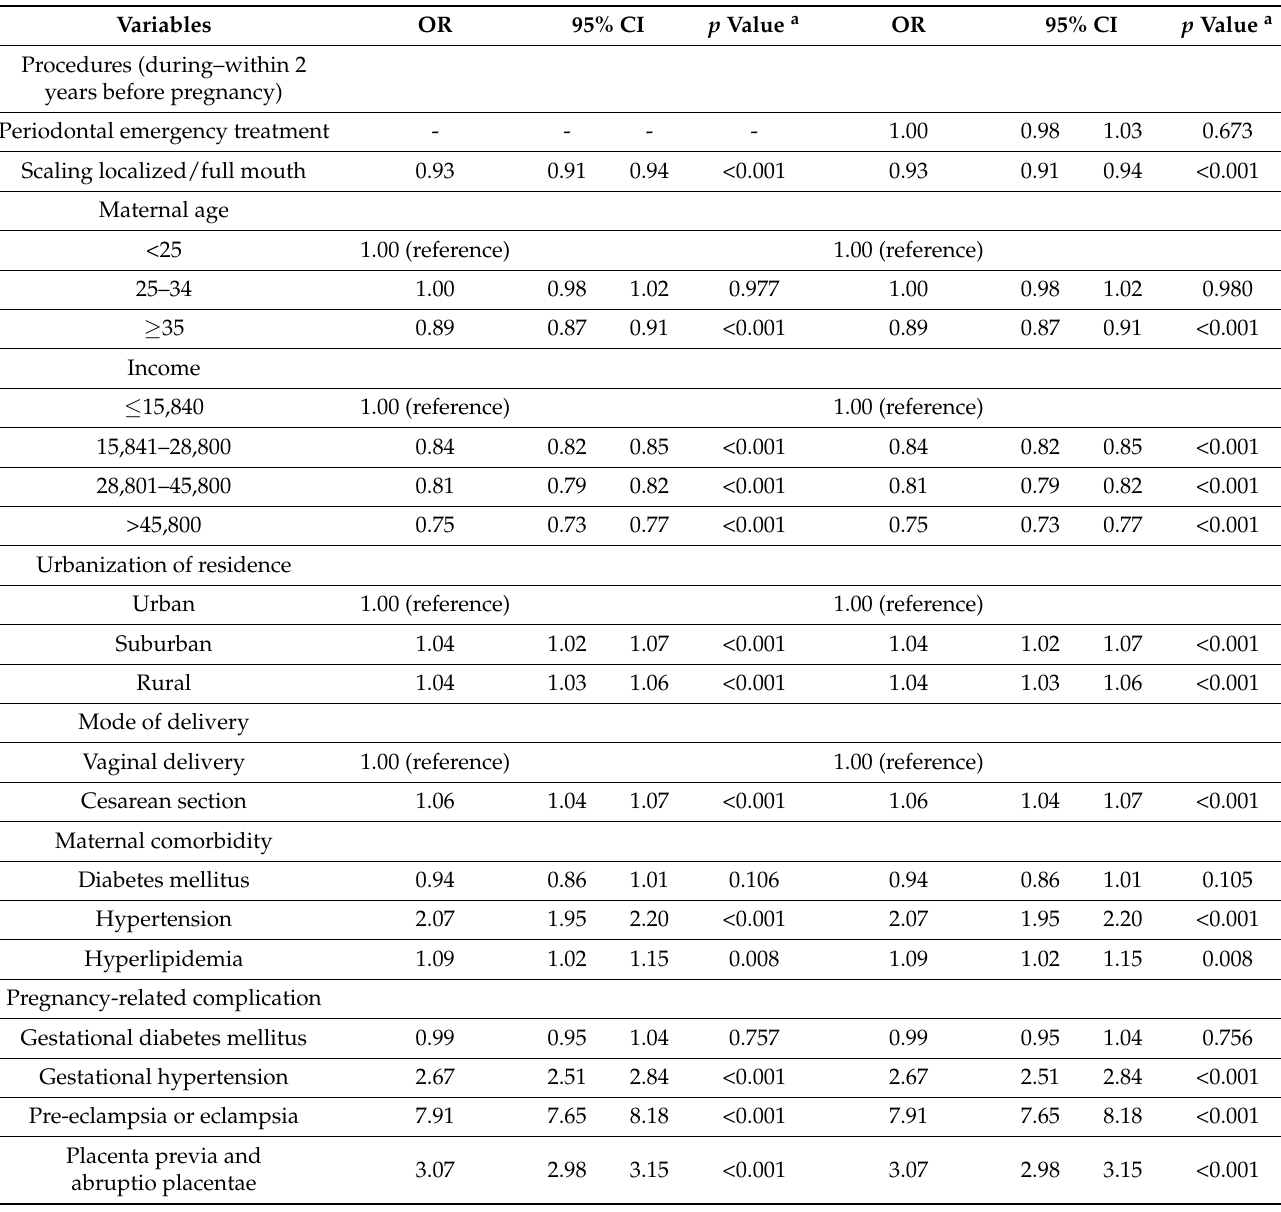
Table 2. Multivariate analysis of factors associated with low birth